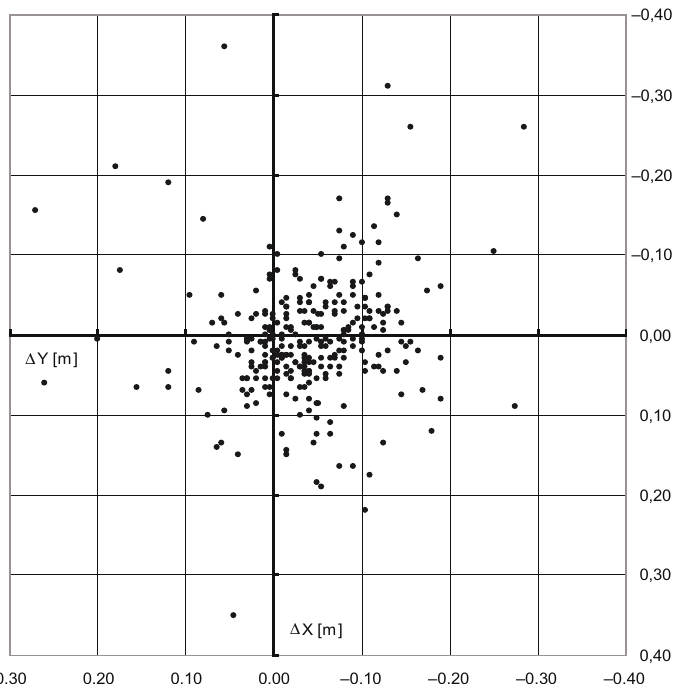
Fig. 4. Coordinate differences of surveyed identical points in relation to DTMMO in Přívoz cad. district